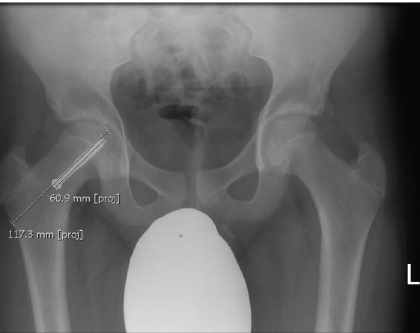
Figure 1: Neck length to screw length ratio measurement. Length of the screw is first measured, and a second measurement in line with the screw extending from the lateral cortex to the articular surface is then made. This gives a ratio that is used for comparative views. This measurement is used to determine proximal femoral neck growth over time. This method of measuring proximal femoral growth accounts for rotation between films.